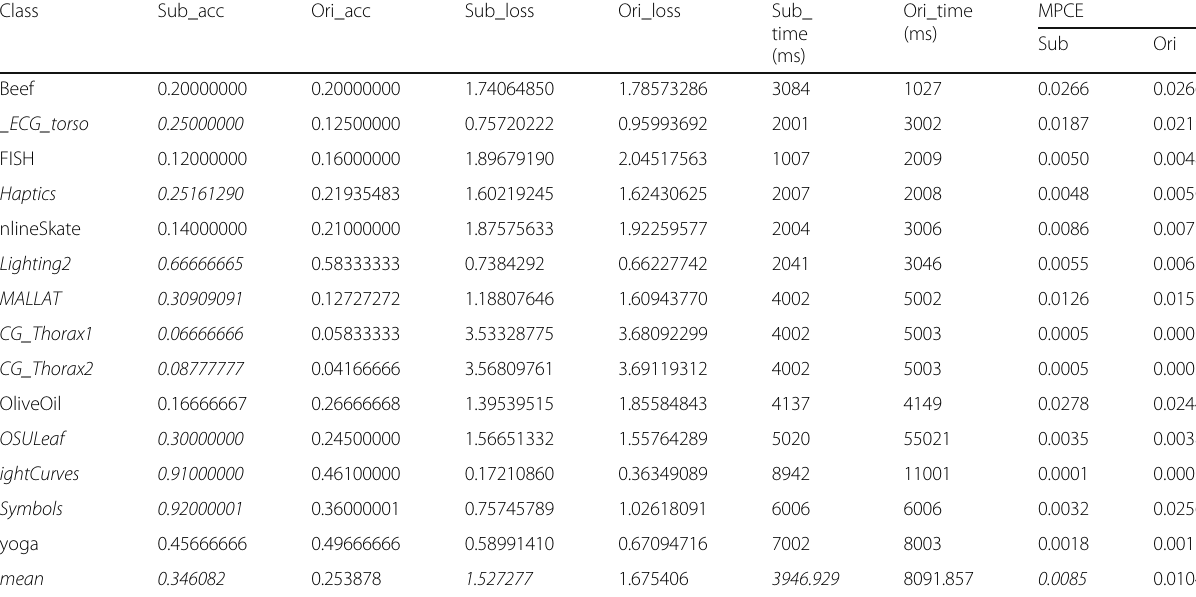
Table 2 Comparison of loss, accuracy, and time of OTS and characteristic subsequences on FCN